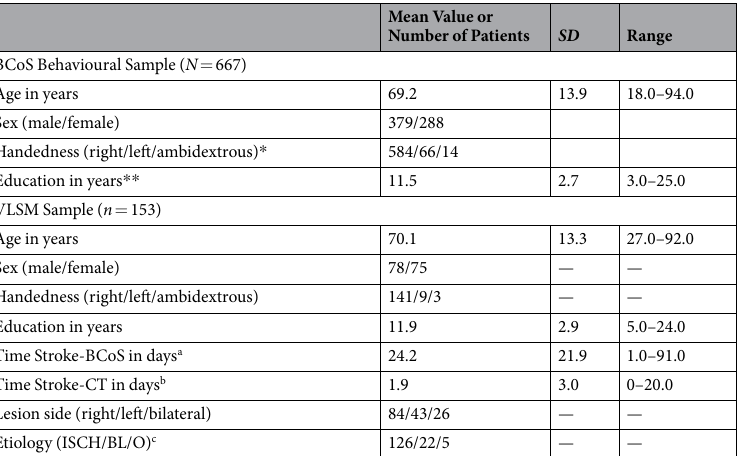
— Table 3. Patient details: Clinical and Demographic Data. Note. VLSM: voxel-based lesion symptom mapping; BCoS: Birmingham Cognitive Screen; a time between stroke and assessment of the BCoS in days; b time between stroke and computer tomography in days for n = 131; c ISCH = ischemic stroke, BL = bleed (haemorrhagic stroke), O = others; * missing values for 2 patients; ** missing values for 6